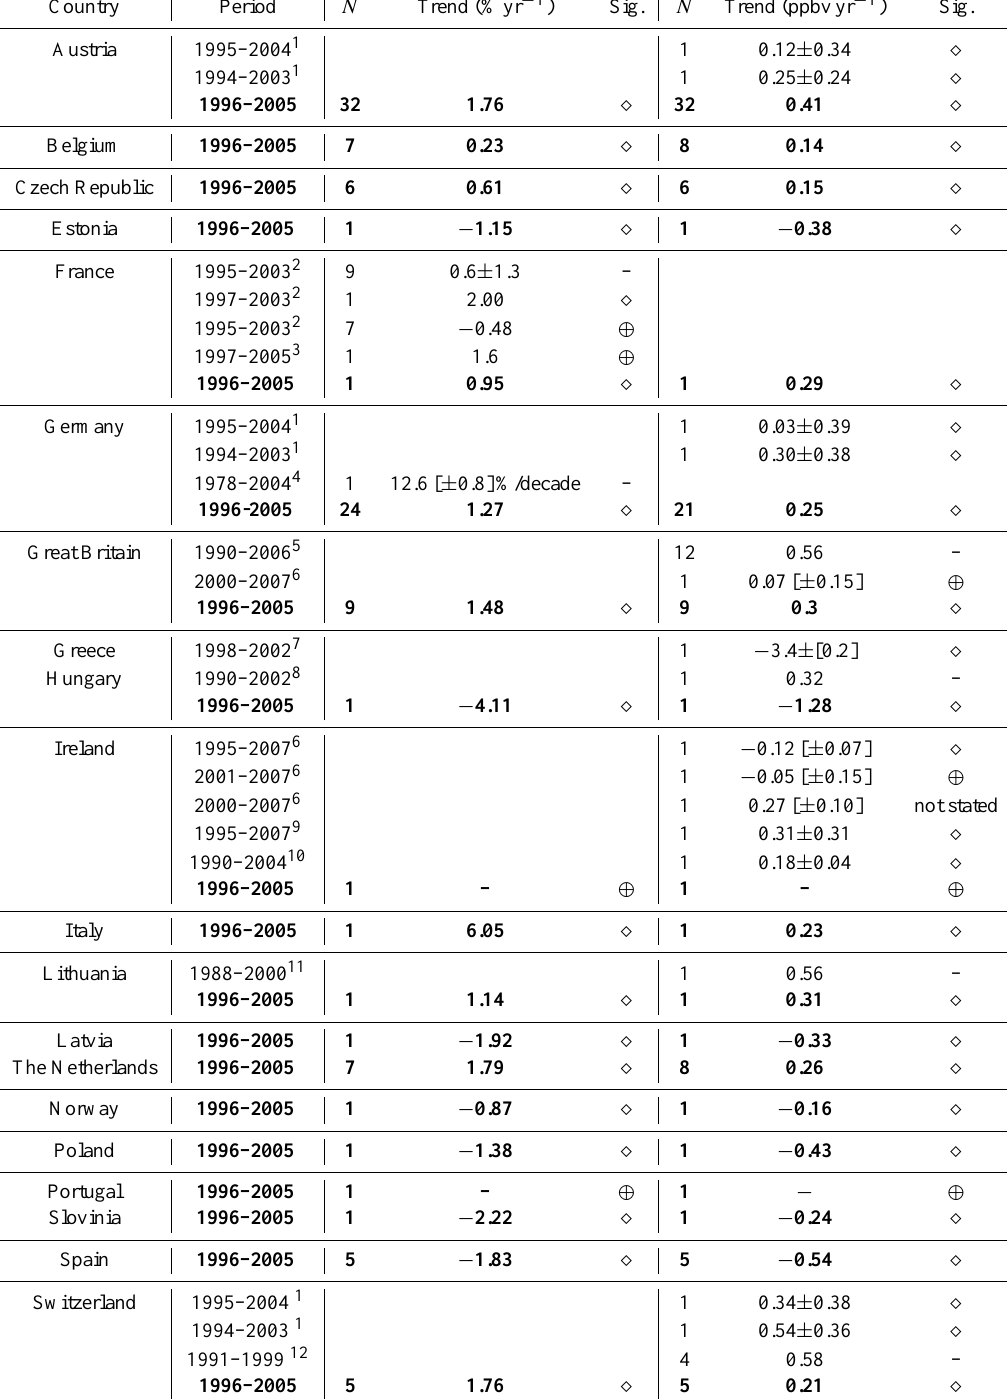
Table 1. Mean trends by country from this study (bold) compared to literature values with 95% confidence limits given, standard error given in square brackets. N =number of measurement sites used to calculate the average trend. Sig=significance of trend, where (cid:5) statistically significant ( p < 0.1), ⊕ not statistically significant ( p > 0.1) and – not